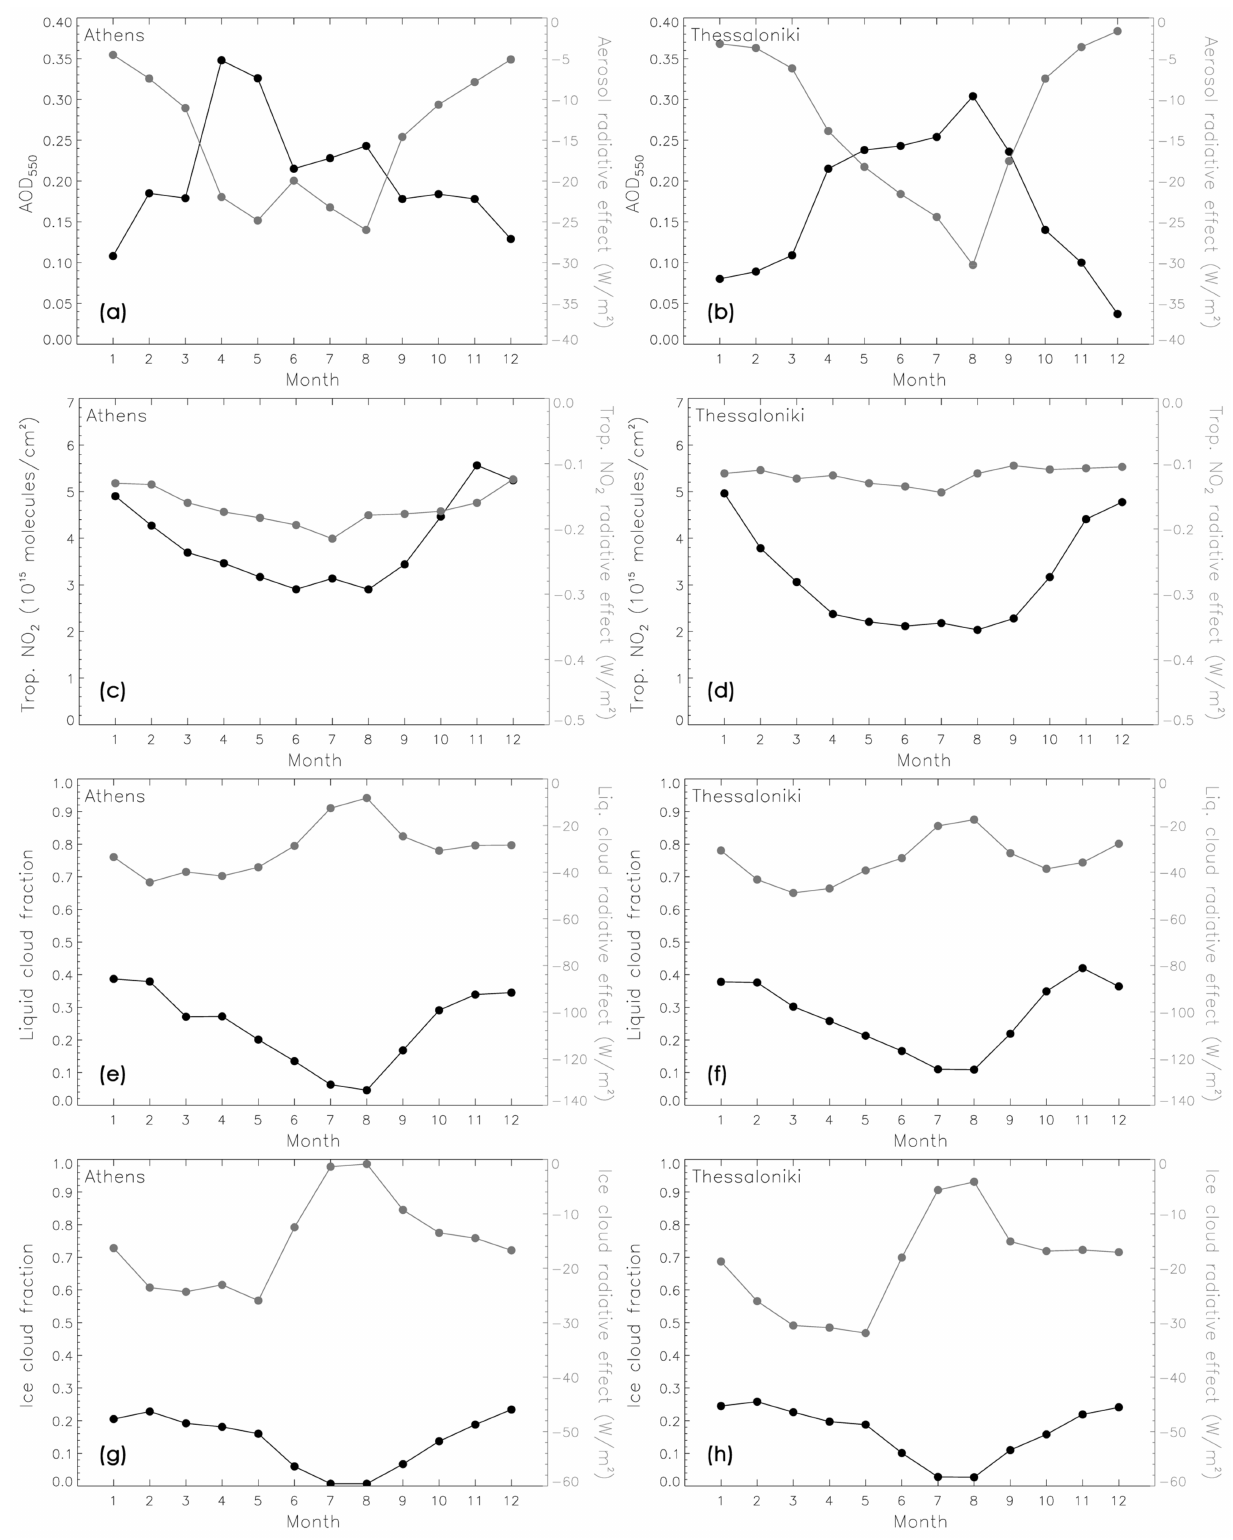
Figure 7. Seasonal variability of AOD 550 , tropospheric NO 2 VCD, liquid cloud fraction and ice cloud fraction (black color) with the corresponding aerosol, tropospheric NO 2 , liquid cloud and ice cloud radiative effect (grey color) for Athens ( a , c , e , g ) and Thessaloniki ( b , d , f , h ) during the period 2005–2019. Aerosol- and cloud-related parameters are from MODIS/Aqua and tropospheric NO 2 from